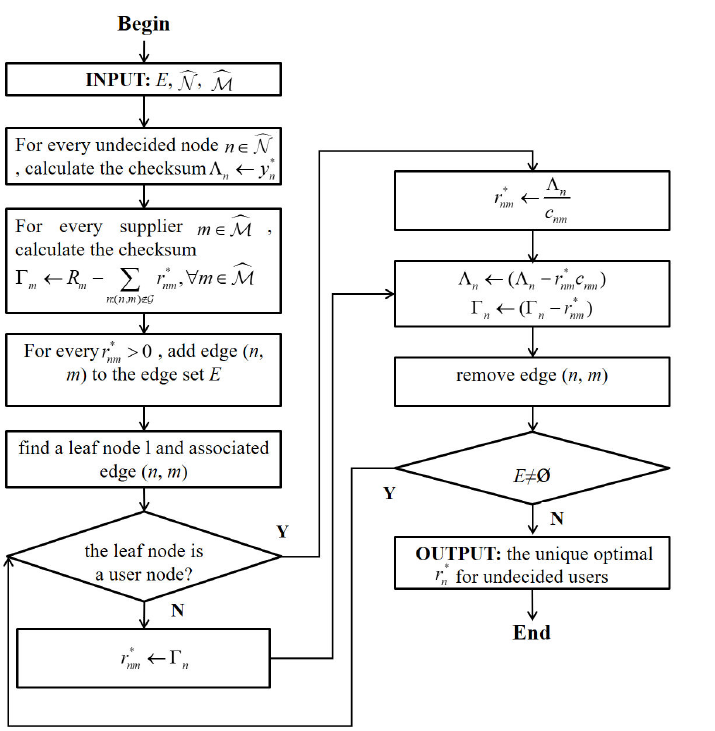
Figure 1. The flowchart of the proposed